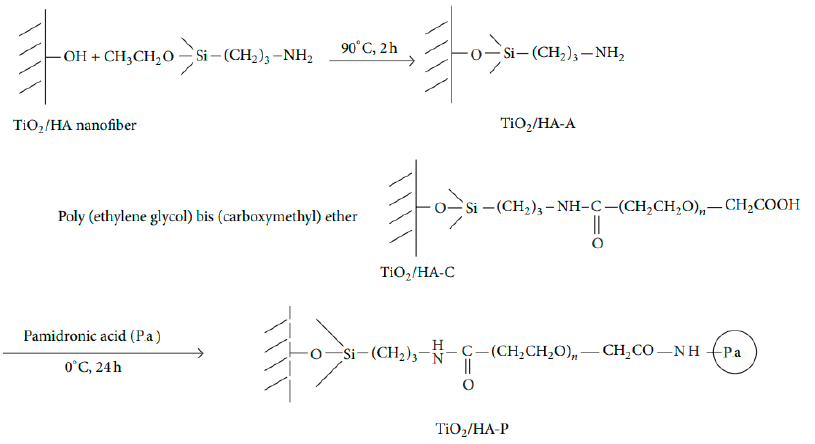
Figure 8. Schematic diagram showing the immobilization of pamidronic acid using a silane coupling agent and PEG on a nanofiber mat composed of Titania and HA ref. [36].